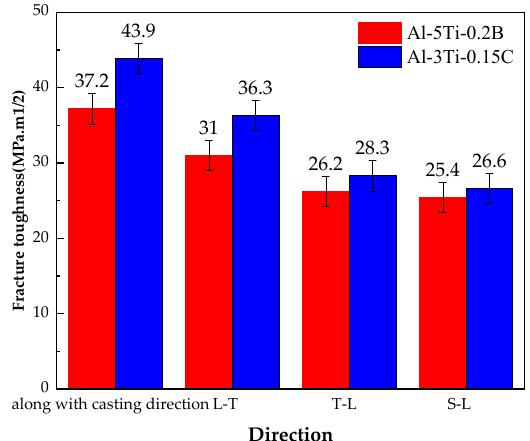
Figure 6. Fracture toughness of 7050 ingot after heat treatment and 7050 ‐ T7651 100 mm plate for different grain refiners in different directions.